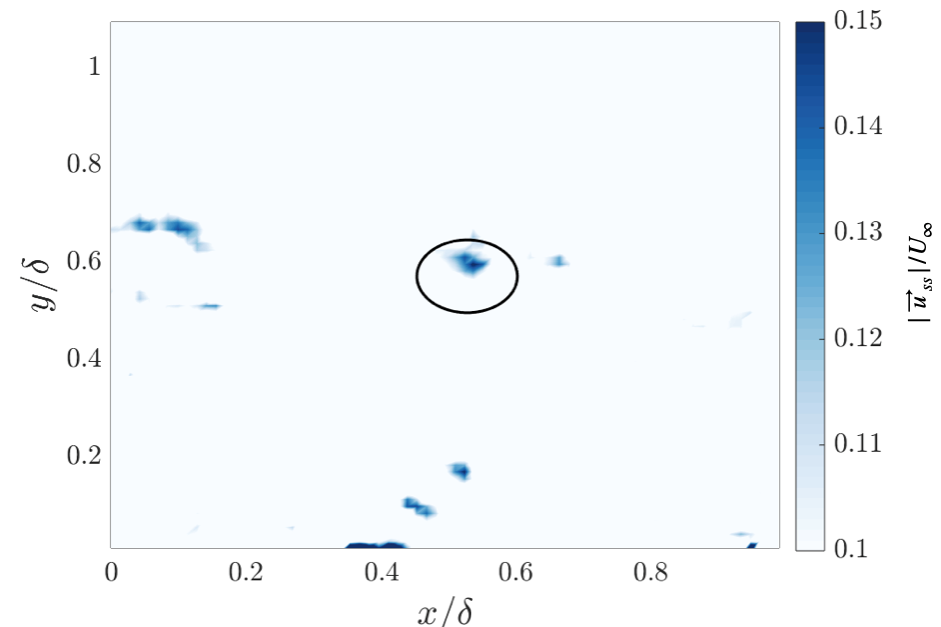
Figure 3. Magnitude of the fluctuating small-scale velocity field | (cid:126) u ss / U ∞ | . The black ellipse shows the position of the detected vortex in the